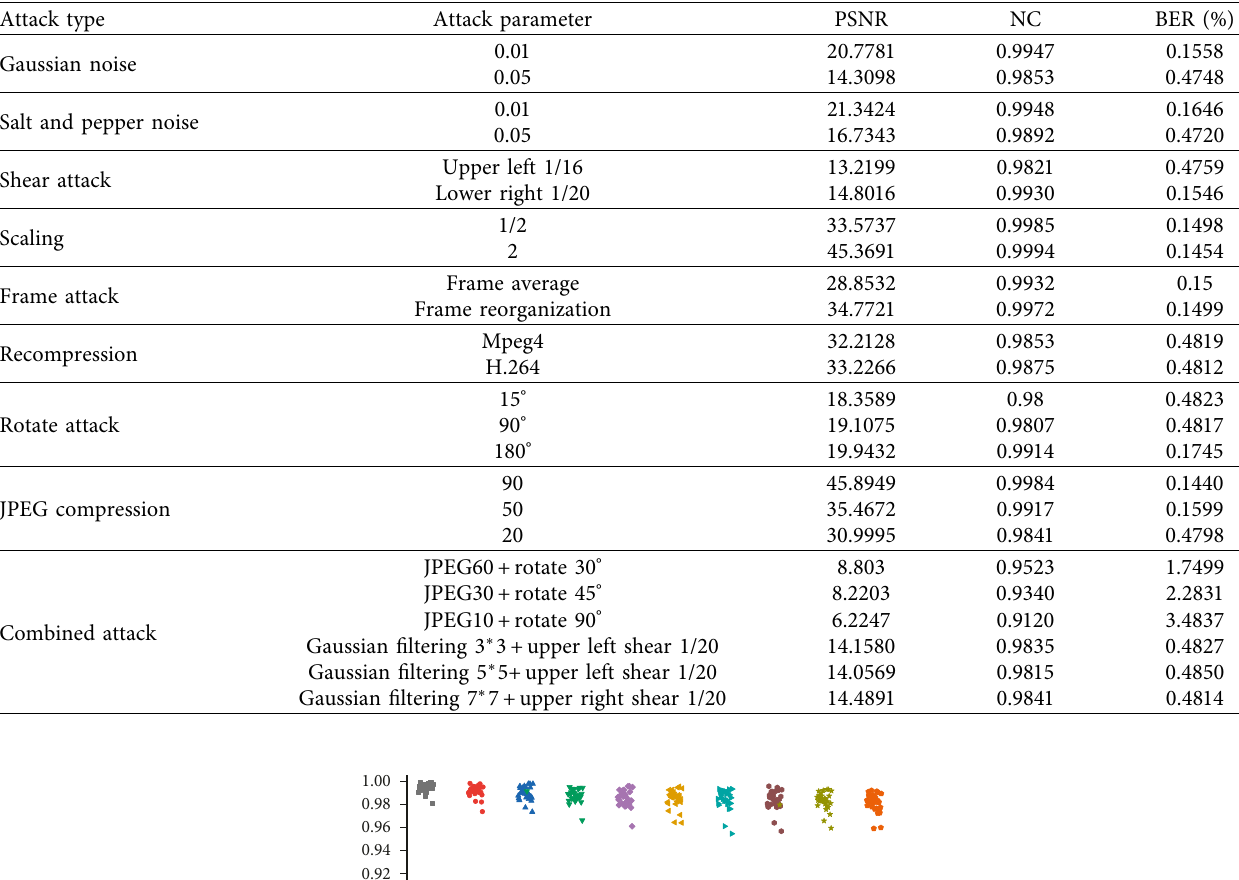
Table 1: Experimental results of video robustness.